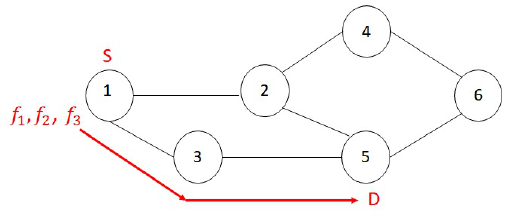
Figure 2. Random placement